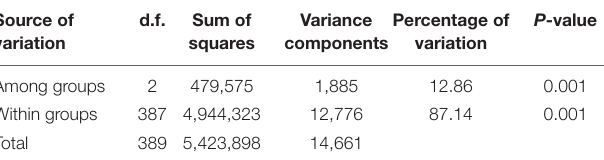
TABLE 3 | Analysis of molecular variance of the genetic differentiation among and within three major groups of 195 accessions. Source of d.f. variation